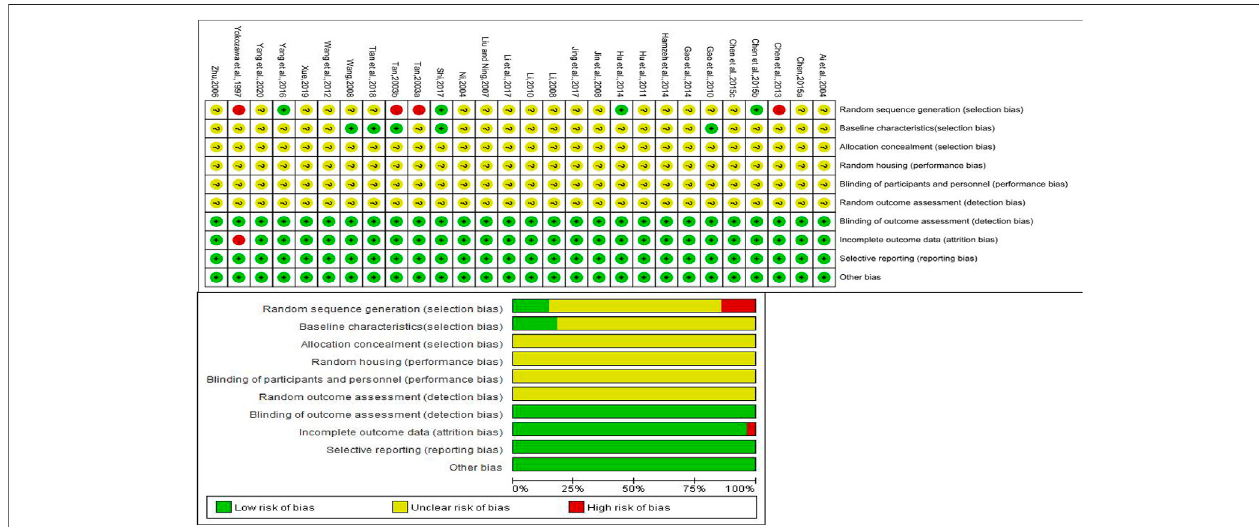
FIGURE 2 | Risk of bias